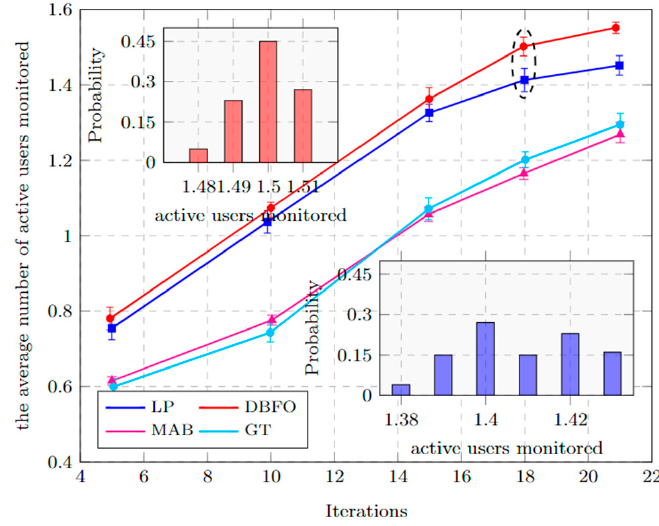
Figure 17. Results of the practical network experiment.